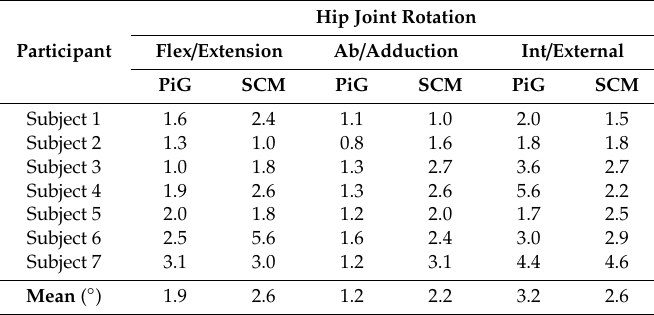
Table 1. Within-subject variability of hip joint rotation over the amputee gait cycle across three trials per participant as calculated by PiG and SCM is shown by the standard deviation, SD.